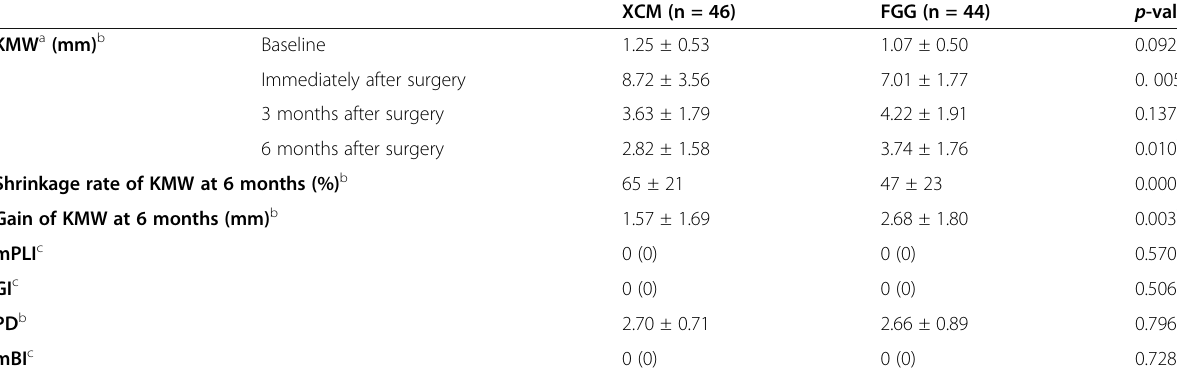
XCM (n = 46) FGG (n = 44) p -value